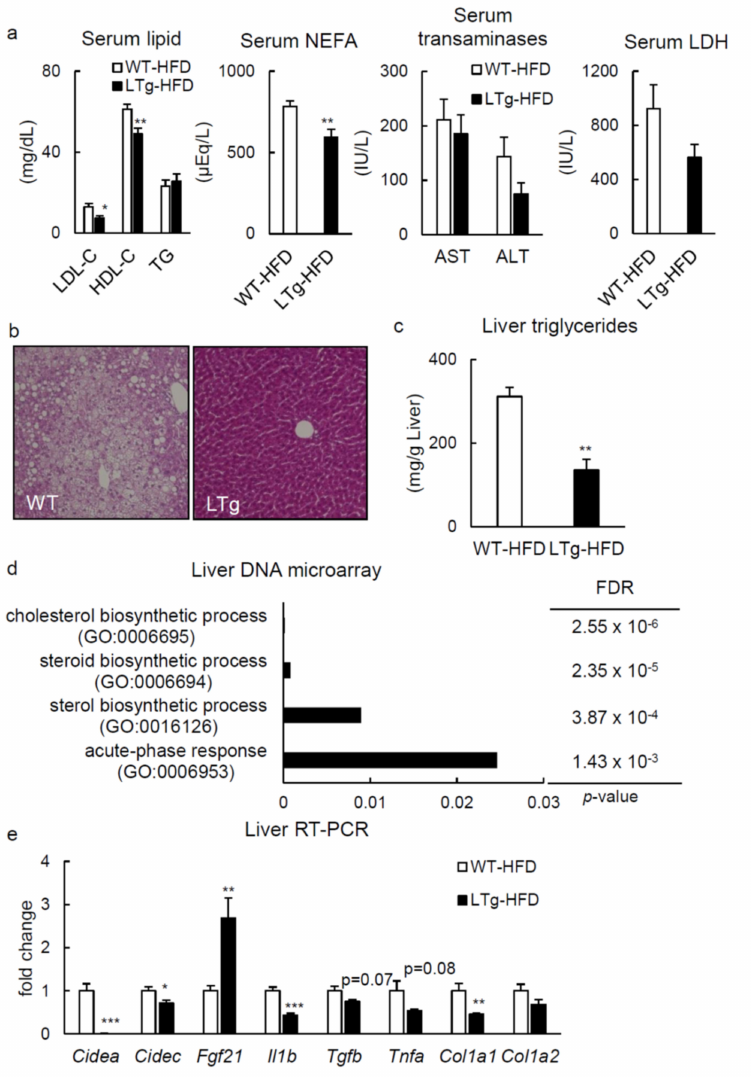
Figure 3. LTg mice under feeding HFD improved serum cholesterol levels and fatty liver. ( a ) Serum low-(LDL-C) and high-density lipoprotein cholesterol (HDL-C), triglyceride (TG), non-esterified fatty acid (NEFA), aspartate (AST) and alanine aminotransferase (ALT), and lactate dehydroge- nase (LDH) levels in HFD-fed mice after overnight fast (14 h) (8–9 mice per group). Values are shown as the mean ± SEM; * p -value < 0.05 and ** p -value < 0.01 ( t test). ( b ) Hematoxylin eosin stains of representative liver samples derived from a WT/LTg mouse under HFD condition ( × 400). ( c ) Hepatic triglyceride levels in HFD mice after overnight fast (14 h) (n = 7–8 mice per group). Values are shown as the mean ± SEM; ** p -value < 0.01 ( t test). ( d ) The ontology terms enriched among the downregulated (<0.67-fold) mRNAs liver from a LTg mouse compared those from a